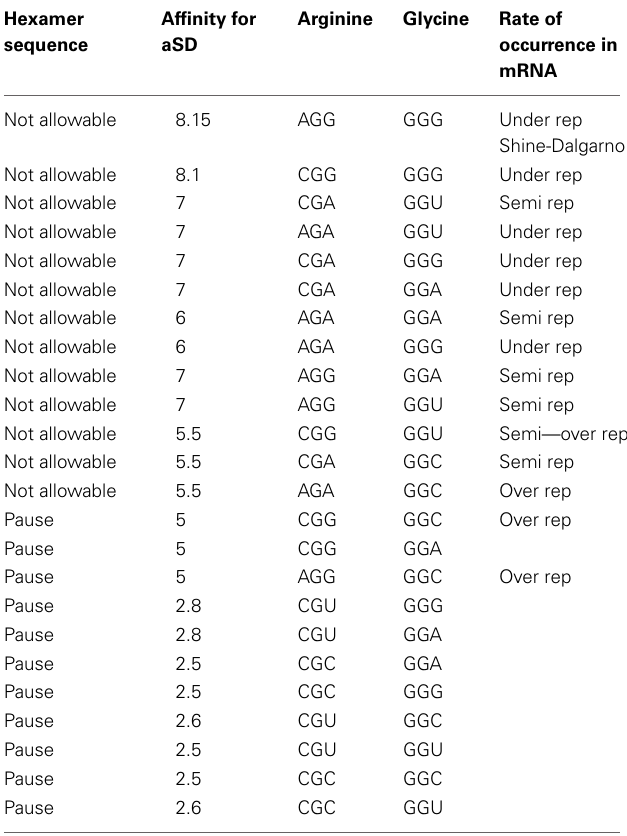
Table 2A | Data showing pausing code (Arginine to Glycine hexamer) relative to its affinity for the aSD site.